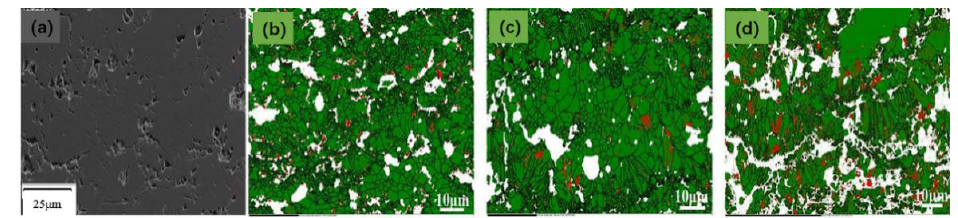
Figure 1. Cross-section backscattered image of ( a ) M 3 , and the EBSD images of polished cross-sections of the YSZ thermal barrier coatings ( b ) M 1 , ( c ) M 2 and ( d ) M 3 .